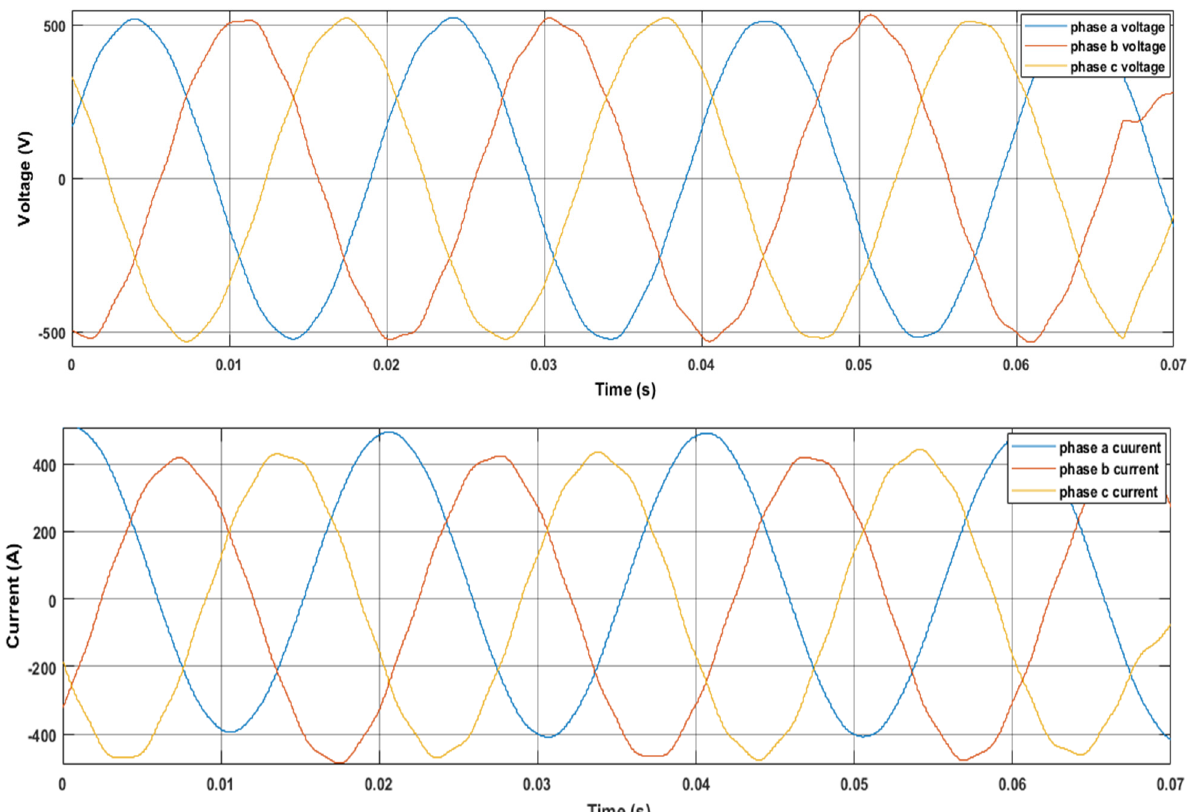
Figure 14. Phase to phase voltage and current for condition without grid source interference.